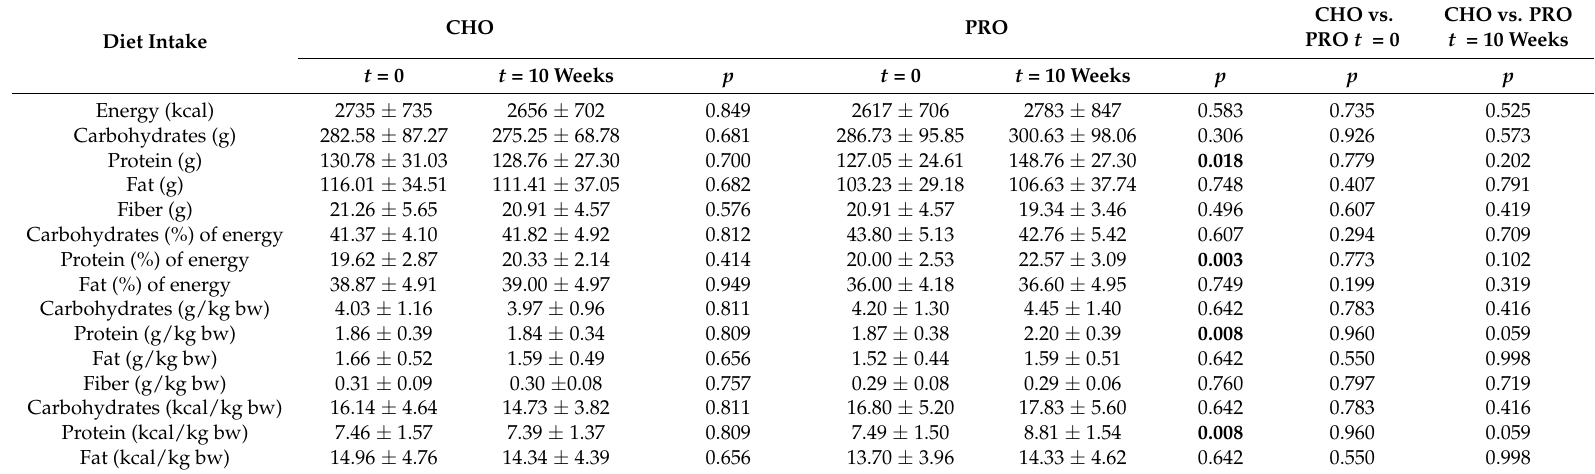
Table 5. Nutrient intake per day after nutritional